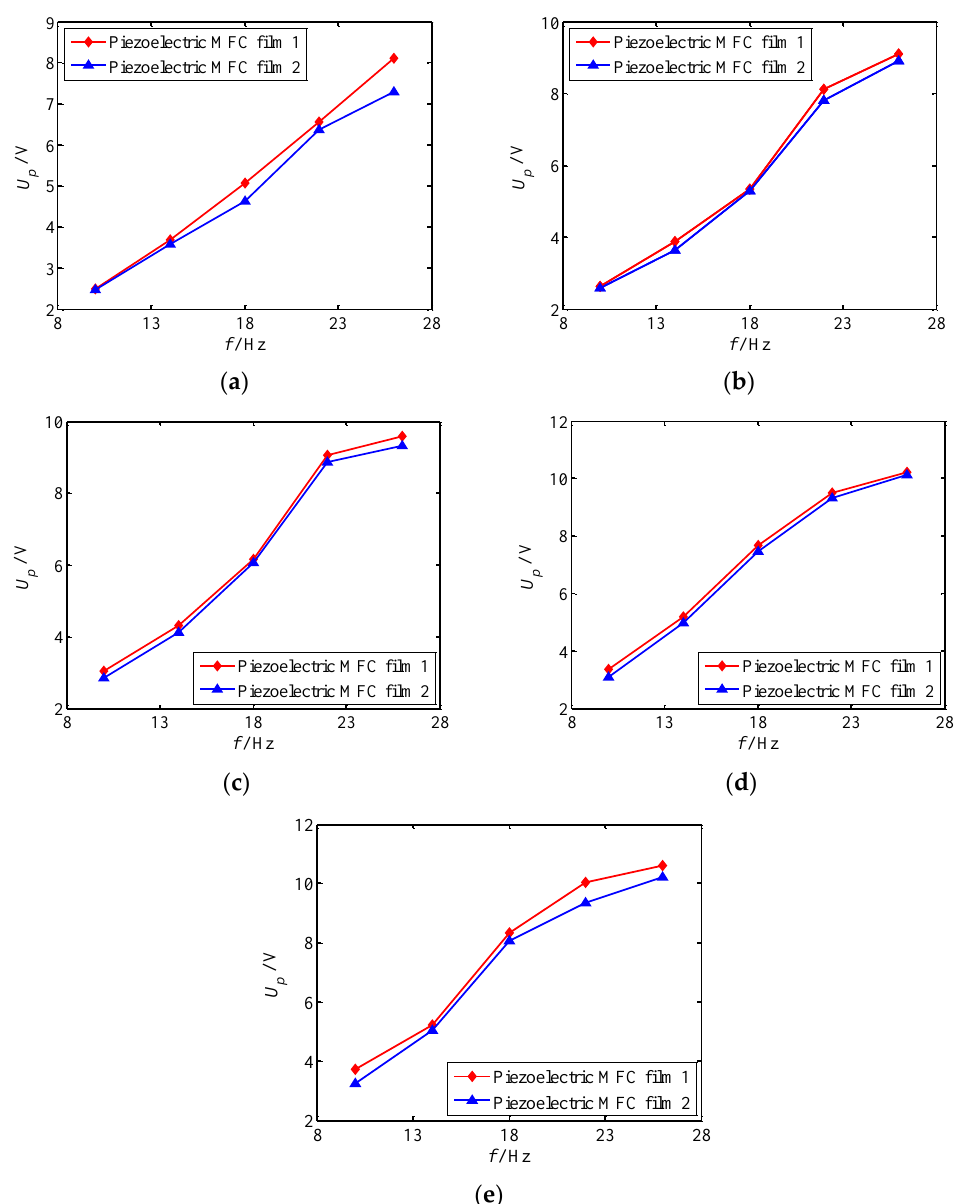
Figure 10. The output voltage varies with the excitation frequency under different load resistance. ( a ) R = 10 kΩ; ( b ) R = 20 kΩ; ( c ) R = 30 kΩ; ( d ) R = 40 kΩ; ( e ) R = 50 kΩ.